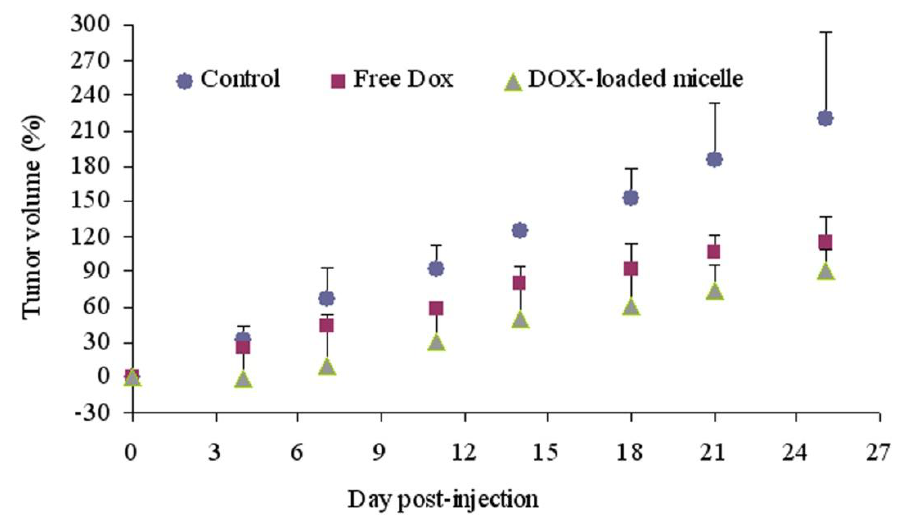
Figure 9. Antitumor effect of free DOX and DOX-loaded micelle in MCF-7 tumor bearing mice. Mice were administered PBS (●) and free DOX (■) and DOX-loaded micelle (▲) i.v at the equivalent 5 mg/kg